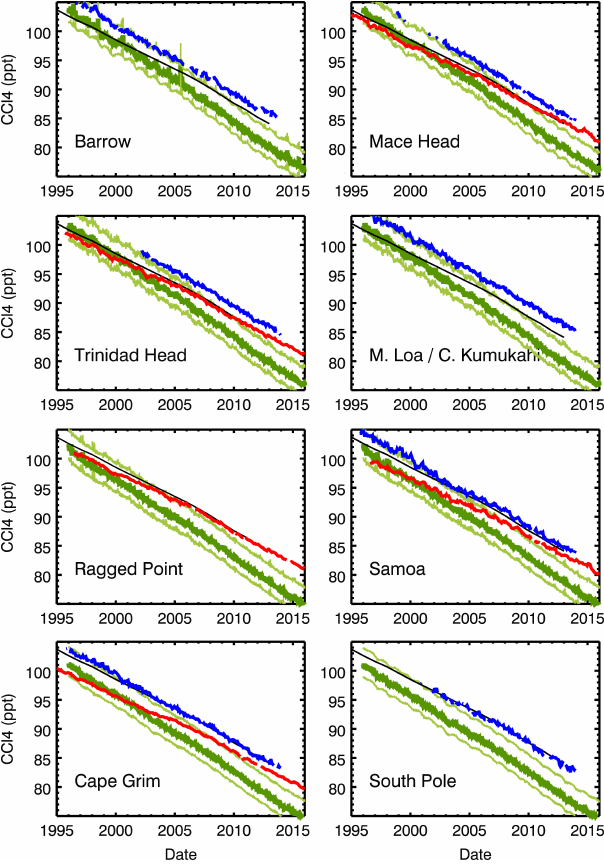
Figure 2. Comparison of modelled surface CCl 4 concentration (ppt) with observations at eight stations in the AGAGE (red line) or NOAA (blue line) networks. Also shown is the CCl 4 global mean surface mixing ratio from WMO (2014) scenario A1 (black line). The dark green line shows model control tracer CTC1, and light green lines show this tracer CTC1 line displaced by + 3 and − 2ppt to aid comparisons with the slope of the NOAA and AGAGE ob- servations. This range is arbitrary but indicates how the model line would be displaced if the CTC1 tracer had been initialised to agree with either the NOAA or AGAGE global mean CCl 4 abundance in